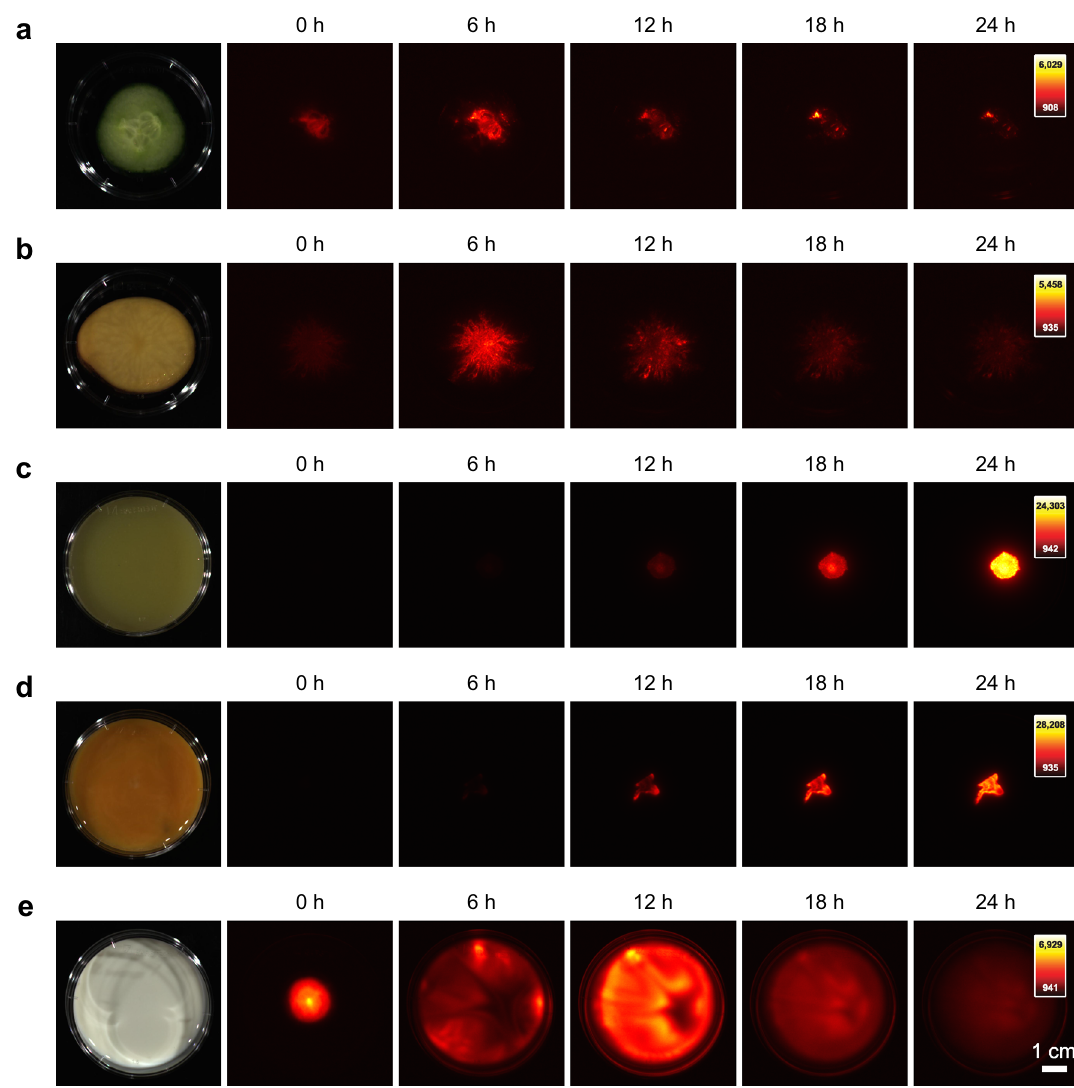
Figure 8. Growth of E. coli Top10 cells on different food products. Food samples were placed in 6 cm dishes and inoculated with Top10 cells chromosomally labeled with ilux2 . Bioluminescence images were taken at room temperature with an Amersham Imager AI 600 RGB after the indicated time periods. The colormap of each time series was scaled to the minimum and maximum pixel values. The following food products and exposure times per bioluminescence image were used: ( a ) cucumber, 1 min, ( b ) raw potato, 1 min, ( c ) mashed potatoes, 5 s, ( d ) egg yolk, 5 s, ( e ) milk, 1 min. Complete time series are shown in Movies